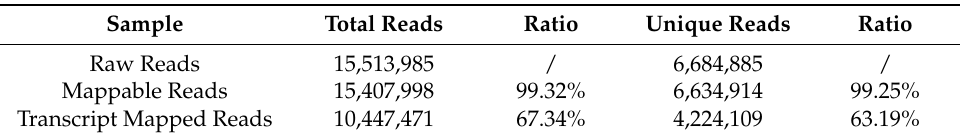
Table 4. Data analysis of degradome sequencing in P. euphratica